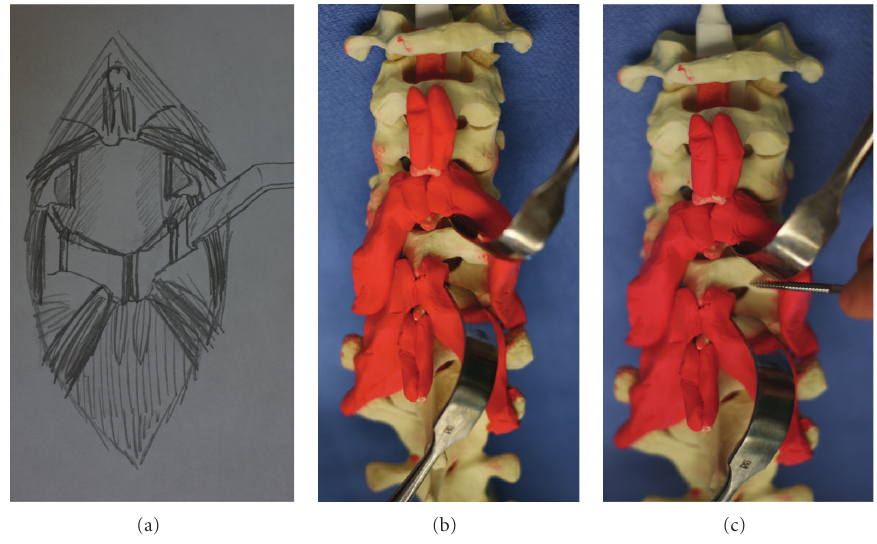
Figure 12: Illustration (a) and sawbones model (b) showing how a muscle-sparing exposure can be applied to a double-door laminoplasty. The deep extensor muscles attaching to the C4 spinous process are pulled laterally and those attaching to the C5 spinous process are pulled distally. The double-door laminoplastycan then be done as with the standard posterior midline exposure with sagittal splitting of the spinous processes and the creation of bilateral laminar troughs which serve as hinges on which the double-door can open, as shown in